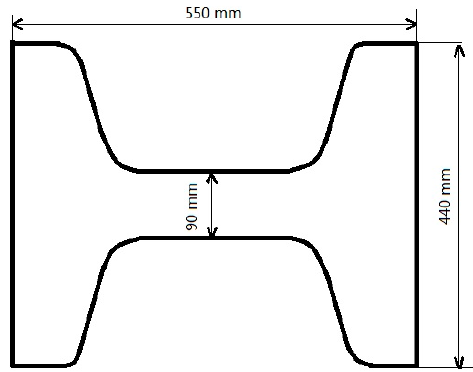
Figure 2. Schematic of the cross-section of the beam blank.